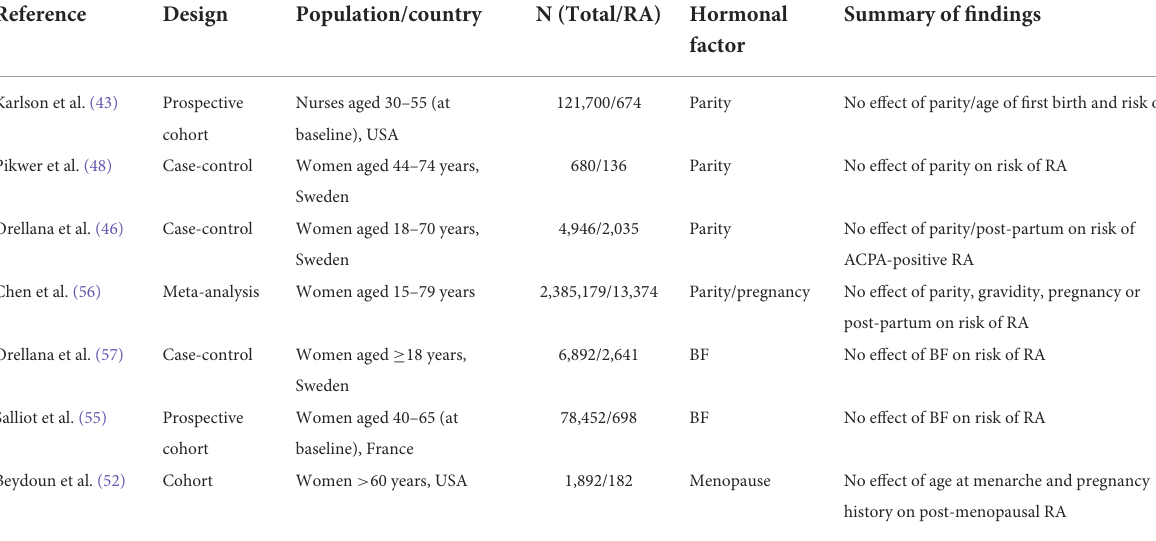
TABLE 2 Epidemiological studies showing no association between endogenous sex hormones and RA